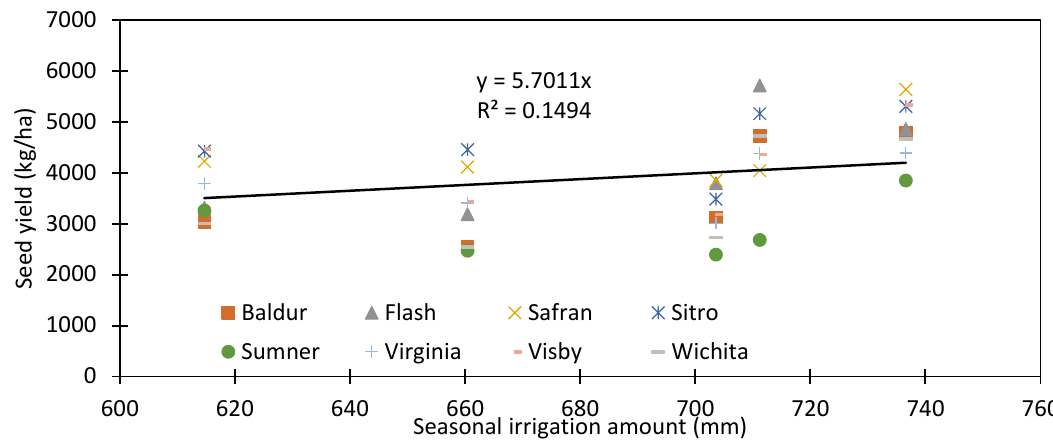
Figure 6. Average and standard deviation of winter canola seed yield.